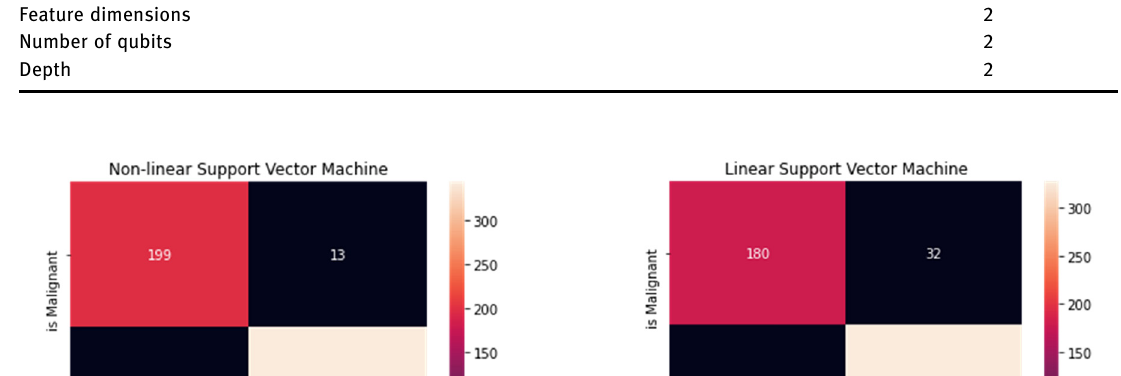
Table 3: Tuned for quantum support vector machine classi fi er Parameters